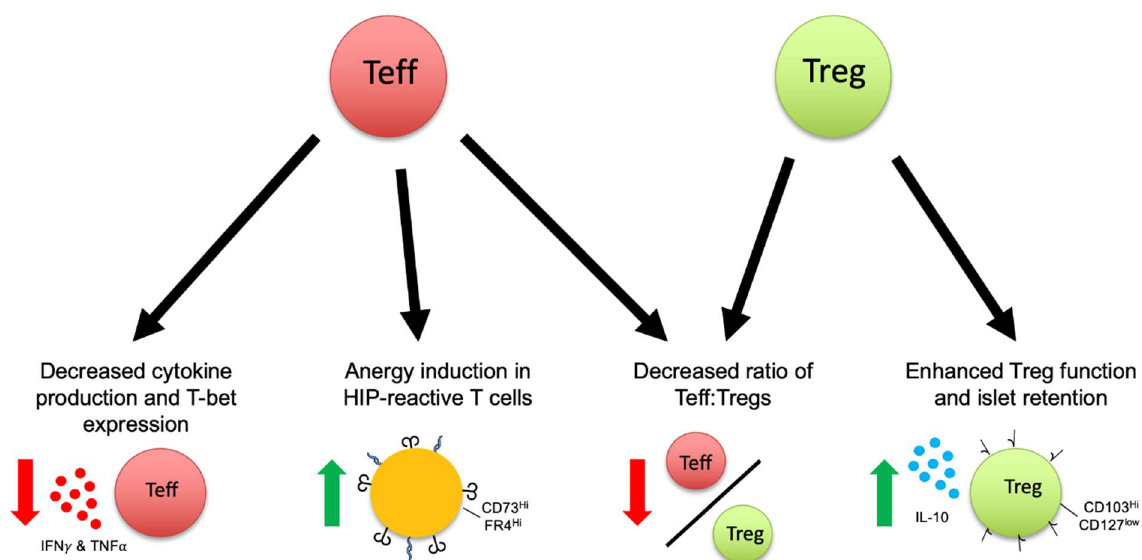
Figure 1. Phenotypic changes in both effector (Teff) and regulatory (Treg) T cells after antigen-specific tolerance induction with a hybrid insulin peptide conjugated to poly(lactide-co-glycolide) nanoparticles. Green arrows indicate an increase, Red arrows indicate a decrease; black arrows signify different effects on T cells after nanoparticle treatment. Line between Teff/Treg indicates the ratio of Teff to Treg.